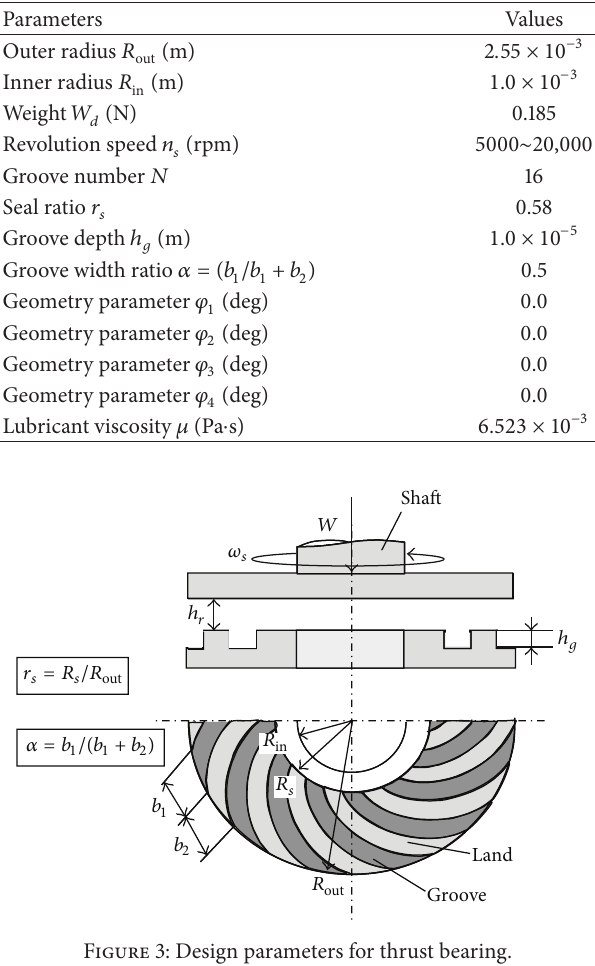
Table 1: Initial 2.5 inch bearing parameters.